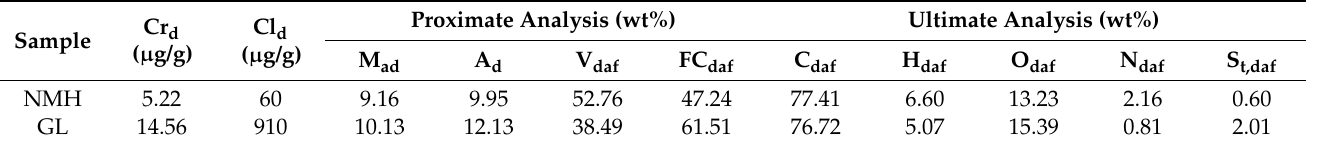
Table 1. Analysis of samples.